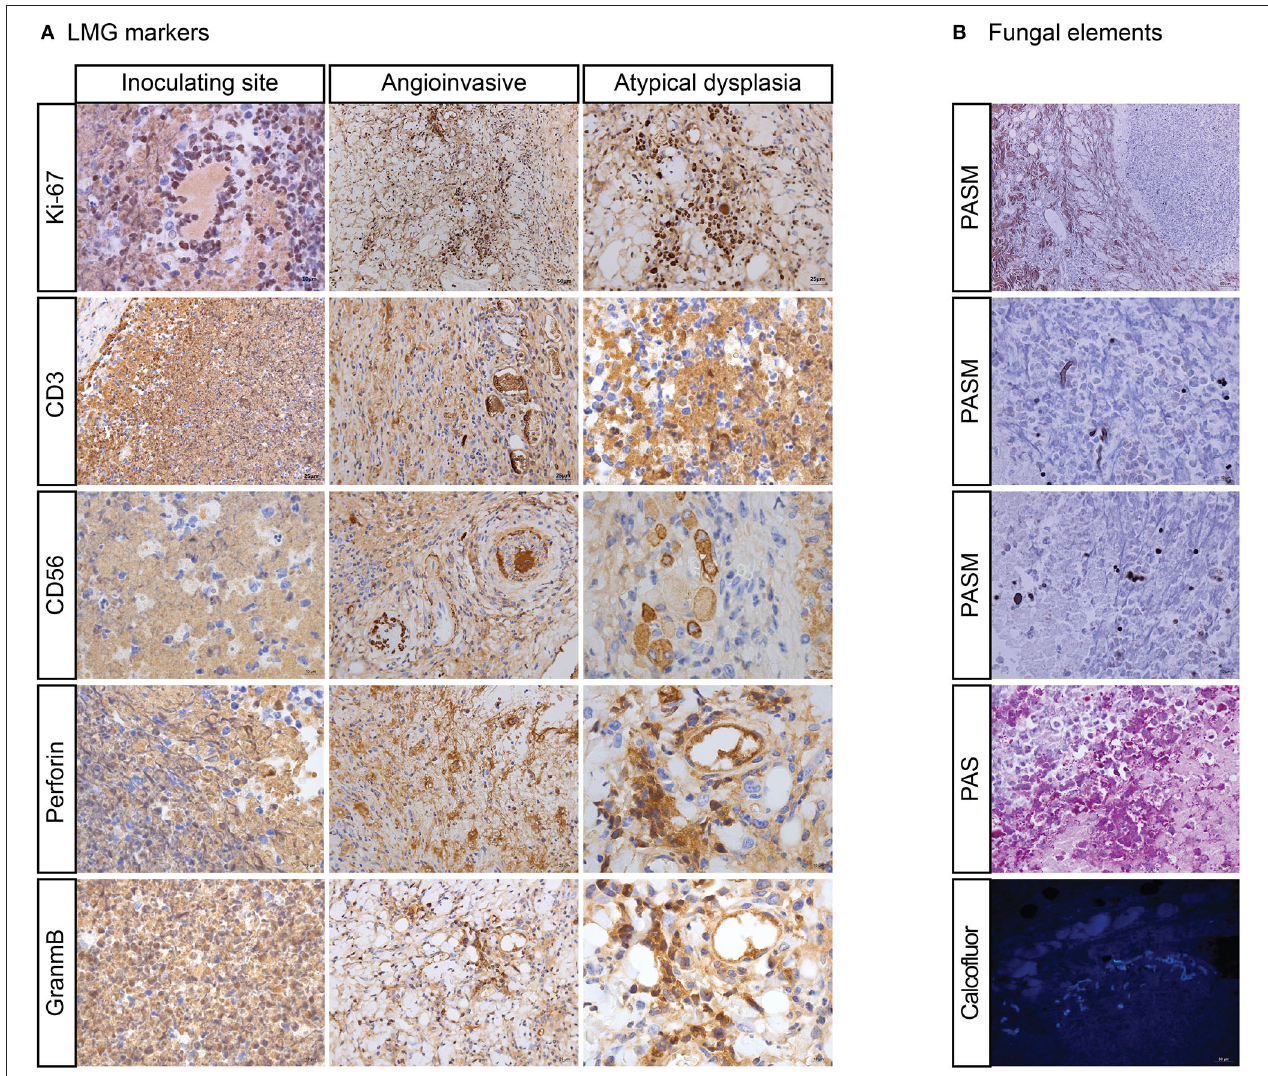
FIGURE 3 | “Mouse infection modules with Rhizopus arrhizus isolated in LMG patient. (A) Shows atypical dysplasia with immunohistochemically positive staining of Ki-67, CD-3, CD-56, PRF, and GZMB. (B) Shows hyphae (broken and disintegrated) and spores (endocytosed) by periodic acid-silver metheramine (PASM), Periodic Acid-Schiff stain (PAS), and Calcofluor